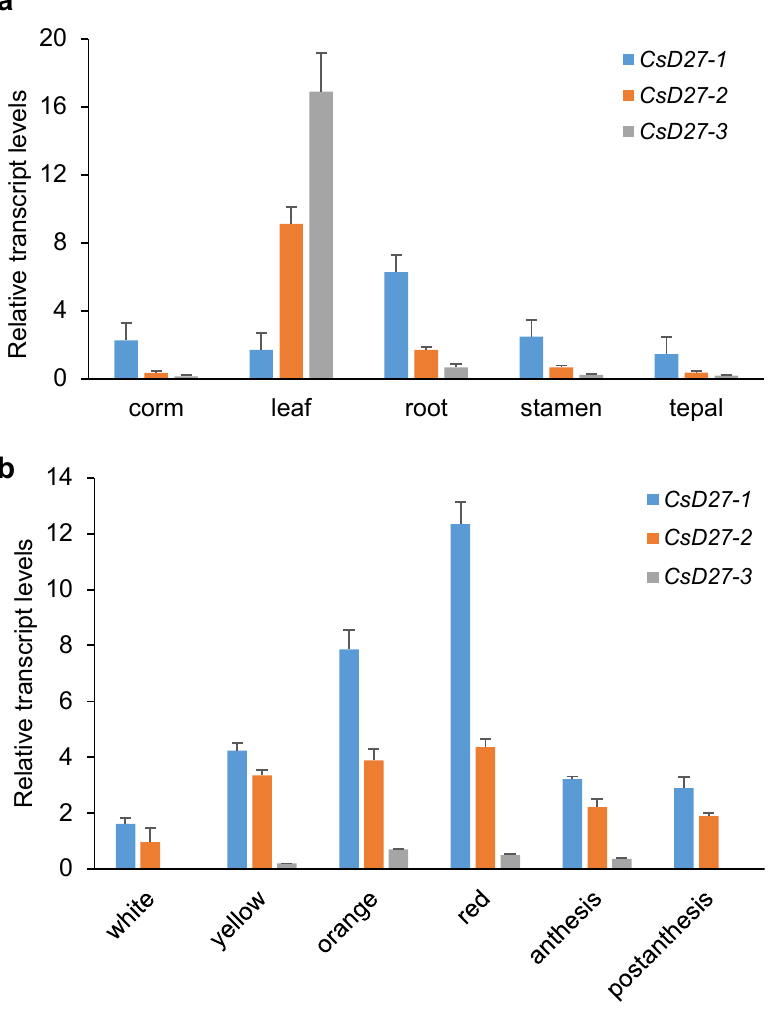
Figure 4. Relative expression levels of CsD27-1 , - 2 and - 3 in vegetative and reproductive tissues investigated by qRT-PCR. ( a ) Transcripts levels in corm, leaf, root, stamen and tepal. ( b ) Expression levels in six developmental stages of the stigma. Bars represent mean ± SD ( n = 3 biological repli- cates).